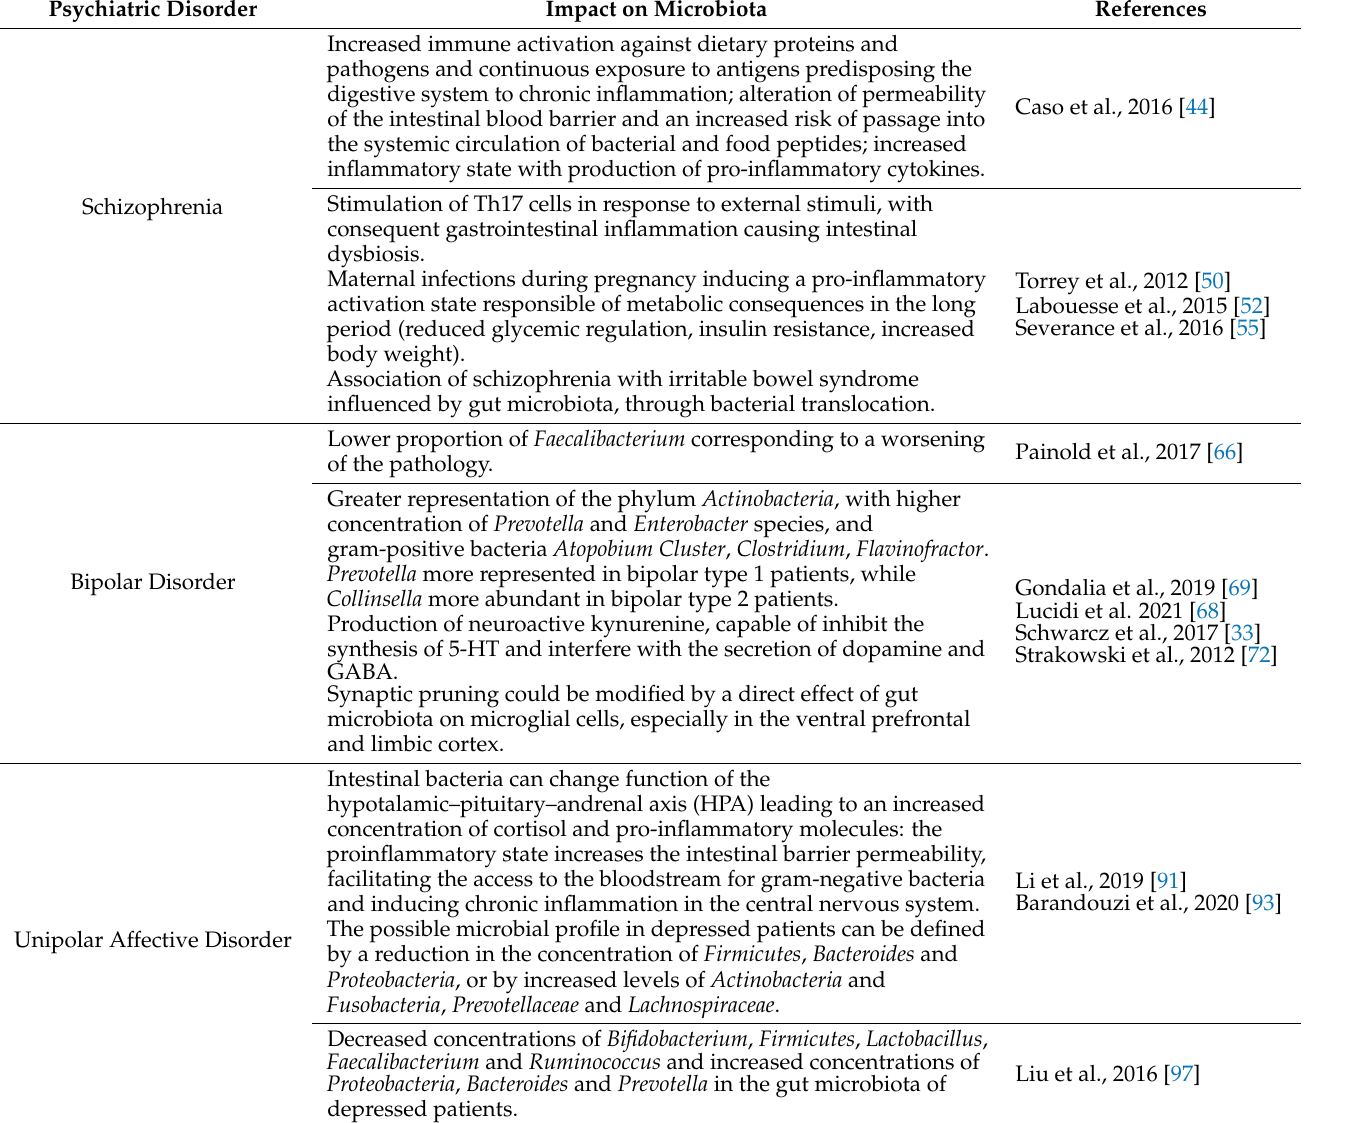
Table 2. The composition of the gut microbiota in patients affected by psychiatric